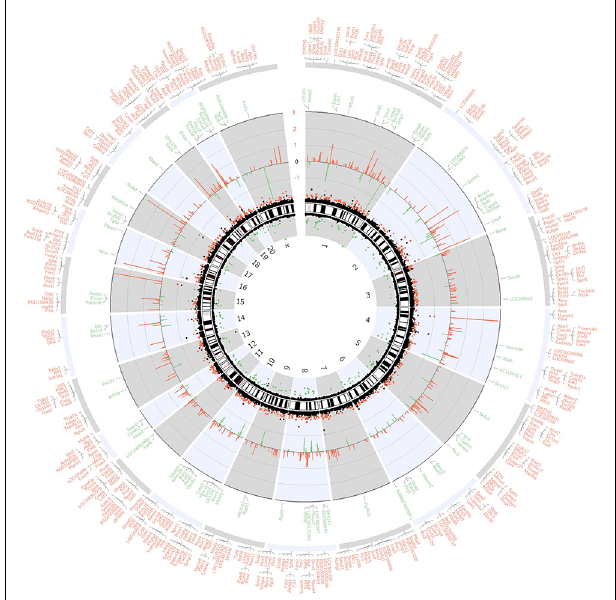
FIGURE 1 | Circos plot of genome-wide coding gene expression differences of rat hippocampi in sevoflurane group vs. control condition ( n = 3). The black innermost ring (with vertical lines) represents autosome ideograms (annotated is the chromosomal number), with the pter-qter orientation in a clockwise direction. Small red lines represent the centromeres within each chromosome. Dots outside the ideograms mark gene expression increase (red dots denote significantly increased mRNA signal), while dots inside mark gene expression decrease (green dots denote significantly decreased mRNA signal). The dot position marks the location of the Illumina 450K probe distribution along the genome. The second outermost black circle represents baseline (zero) and the β -value difference between isoflurane anesthesia and control condition. Red lines signify increased gene expression regions and green lines signify decreased gene expression regions, with the length of each line representing the difference level ( p < 0.05). The last two circles show the RefSeq genes associated with different signal intensity ( p < 0.05, and within the Ensembl database). Outer circle (red) shows genes with increased signal, and inner circle (green) shows genes with decreased